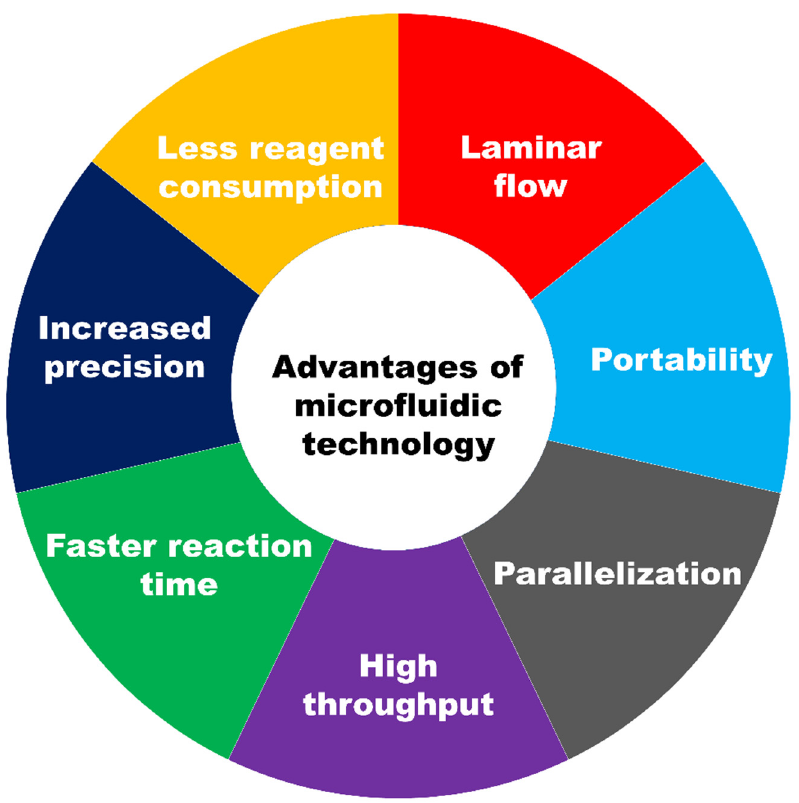
Figure 2. Schematic showing various advantages of microfluidic technology.